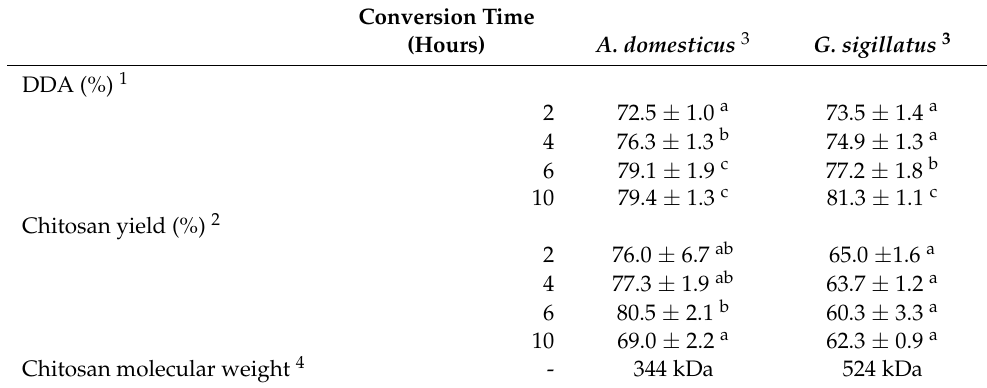
Table 2. Yield and degree of deacetylation (DDA) of cricket chitin converted to